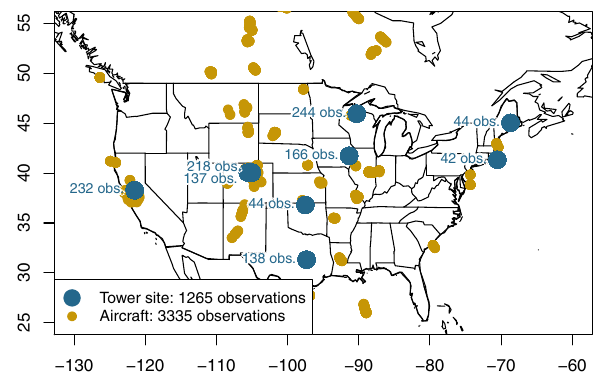
Figure 2. Available in situ methane measurements for May to September